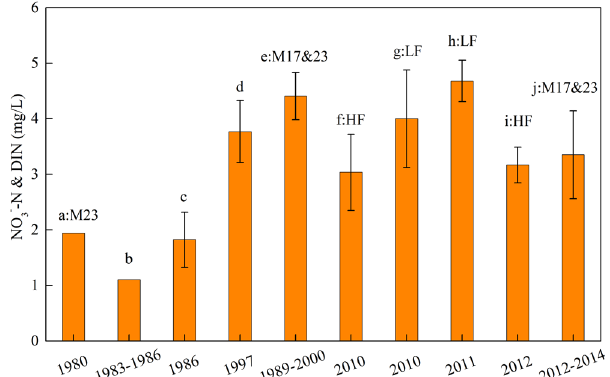
Figure 4. [NO 3 − –N] (mean ± sd) in the Yellow River from Tongguan (M13) to the downstream in different years. The branch gives the range of the data, and the histogram gives the average value. ( a ) Samples from Luokou station (M23) during 1980 (n = 24) 22 ; ( b ) Samples from lower part of river from November 1983 to August 1986 23 ; ( c )Samples at August 1986 (n = 5) 24 ; ( d ) Annual average concentration of NO 3 − –N in the seven mainstream stations during 1997 17 ; ( e ) Average concentration of DIN in the two mainstream stations (M17 and M23) from 1989 to 2000 25 ; ( f ) Samples in the high flow season in this study (n = 14); ( g ) Samples in the low flow season in this study (n = 14); ( h ) Samples collected from Tongdaoguai (M9) to Lijin (M26) during October 2011(n = 13) 16 ; ( i ) Sample in the high flow season during 2012 (n = 9) 26 ; (j) Average concentration of NO 3 − –N in two mainstream stations (M17 and M23) from 2012 to 2014 in this